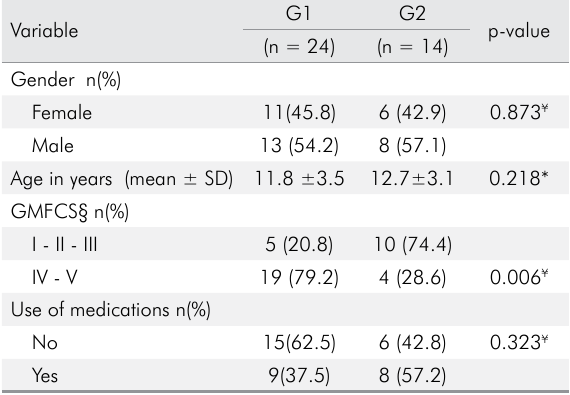
Table 1. Distribution of individuals with CP according to presence of moderate gingivitis (G1) or mild gingivitis (G2).